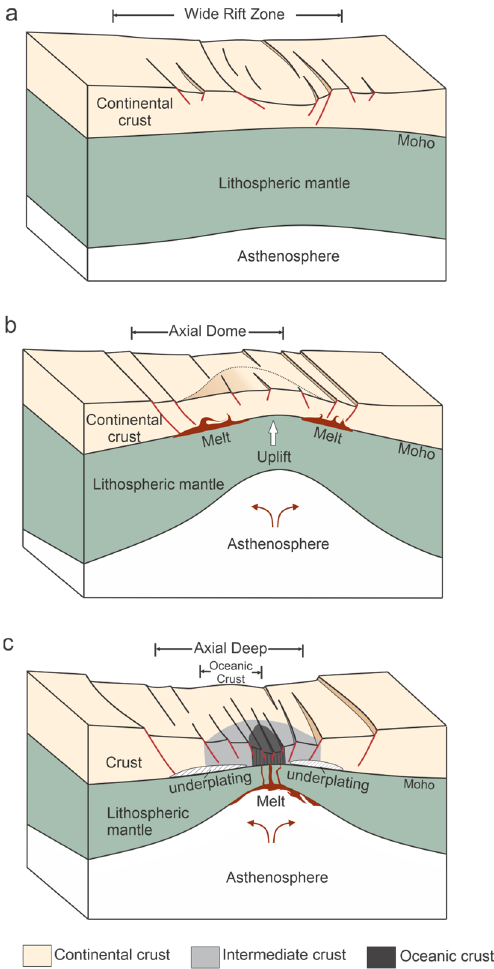
Figure 11. Conceptual model of initial oceanization. ( a ) Early rift initiation, after the first two rifting stages (30–35 Ma). ( b ) Mantle upwelling and topographic uplift concentrated in the weak zones. ( c ) Nucleated normal-fault systems controlled the final breakup and formation of the oceanic crust.